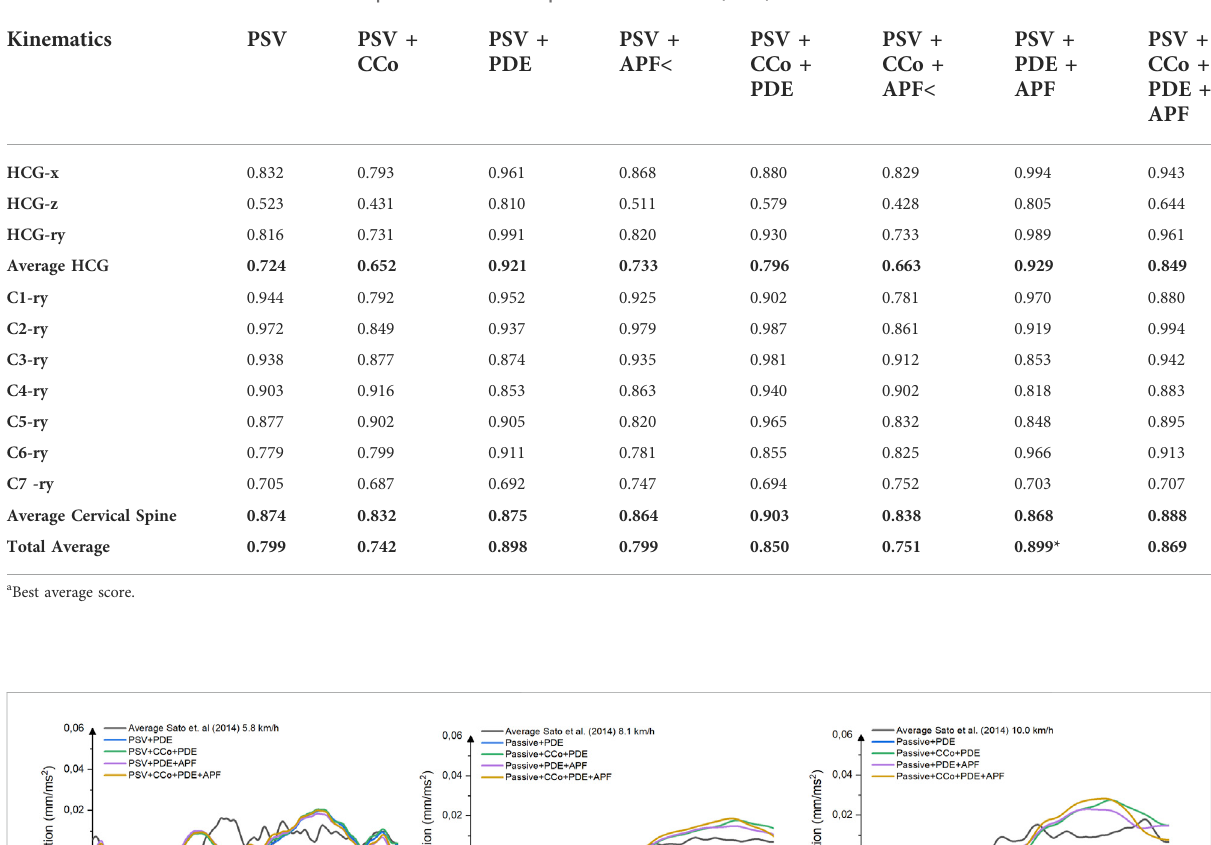
TABLE 5 CORA Score of Head and Cervical Spine Kinematics compared to “ Sato et al. (2014) 5.8 km/h ” .